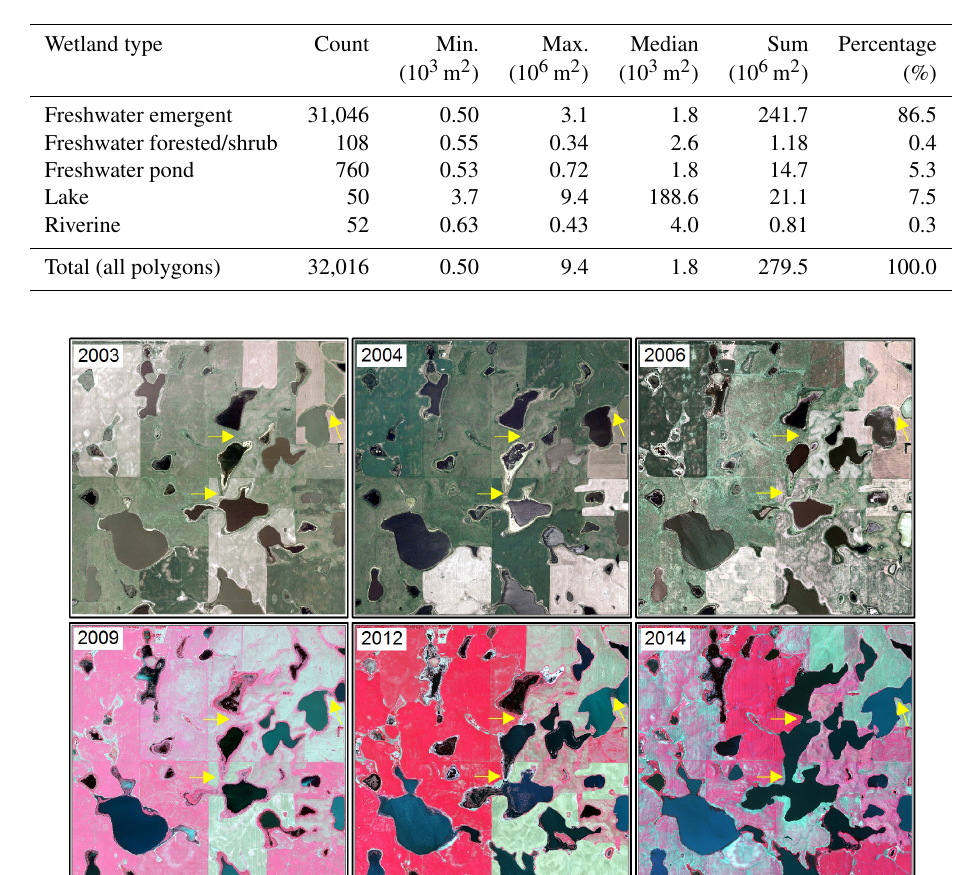
Table 1. Summary statistics of the National Wetlands Inventory (NWI) for the Pipestem subbasin, North Dakota.